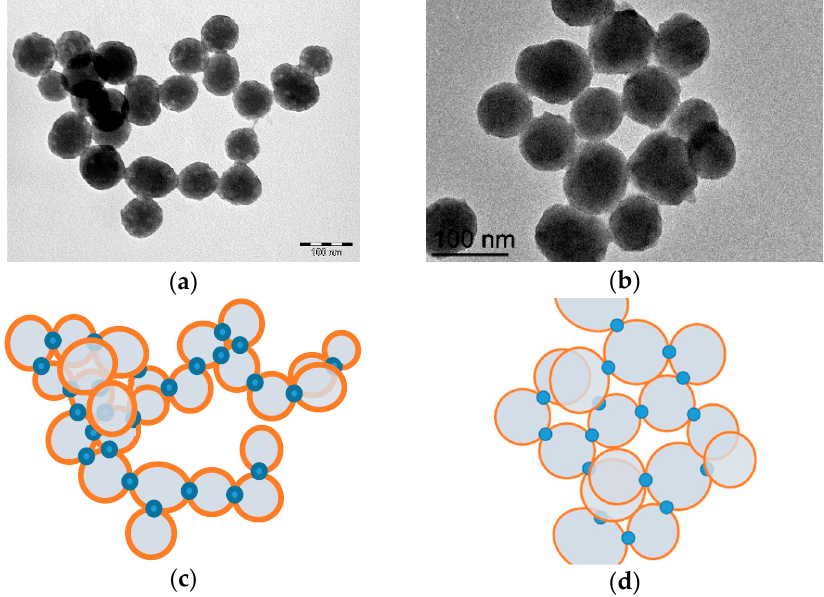
Figure 3. TEM images of SiO 2 @PW ( a ) and SiO 2 @PMo ( b ). Relative schematic potential interactions ( c ) and ( d ) are represented with blue circles.